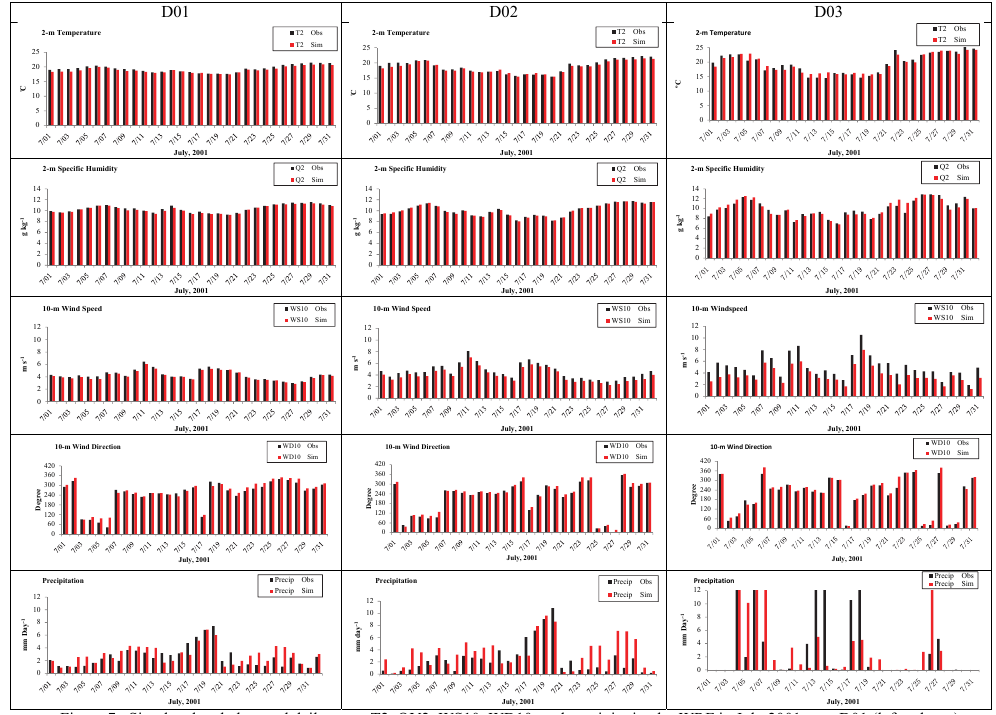
Figure 7. Simulated and observed daily mean T2, QV2, WS10, WD10, and precipitation by WRF in July 2001 over D01 (left column), D02 (middle column), and D03 (right column).